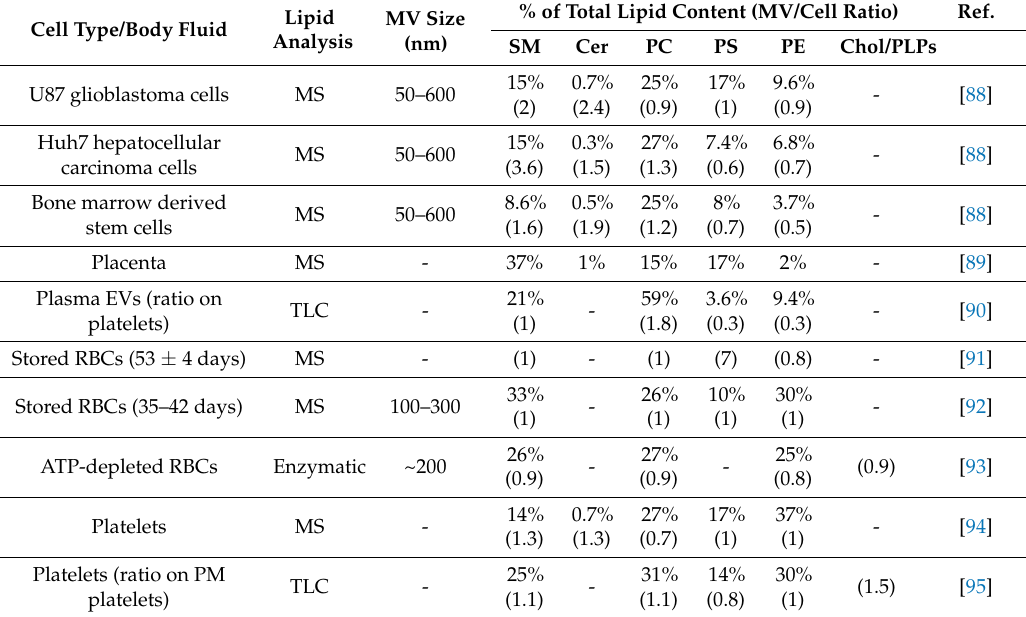
Table 1. Lipid content in microvesicles and enrichment as compared to the originating cells. Data are expressed as percent of total lipid quantified and as MV/cell ratios (brackets), except when specified. Percentages or ratios were calculated from raw data when furnished or estimated on graphs. MS, mass spectrometry; TLC, thin layer chromatography; PM, plasma membrane; -, not determined; SM, sphingomyelin; Cer, ceramide; PC, phosphatidylcholine; PS, phosphatidylserine; PE, phosphatidylethanolamine; chol, cholesterol; PLPs, phospholipids. Lipid Cell Type/Body Fluid